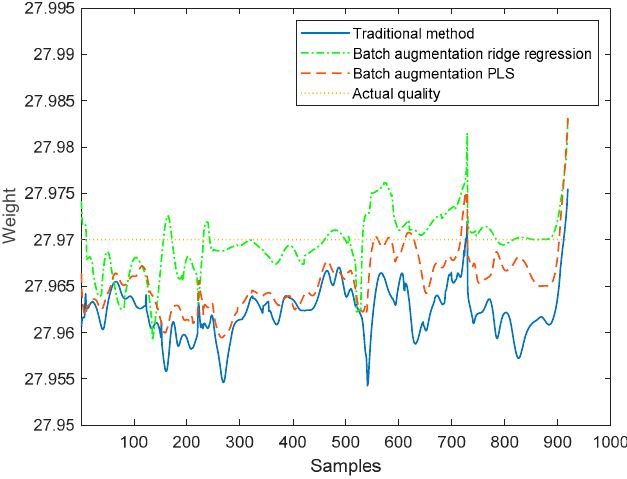
Figure 11. Quality prediction of batch 65.